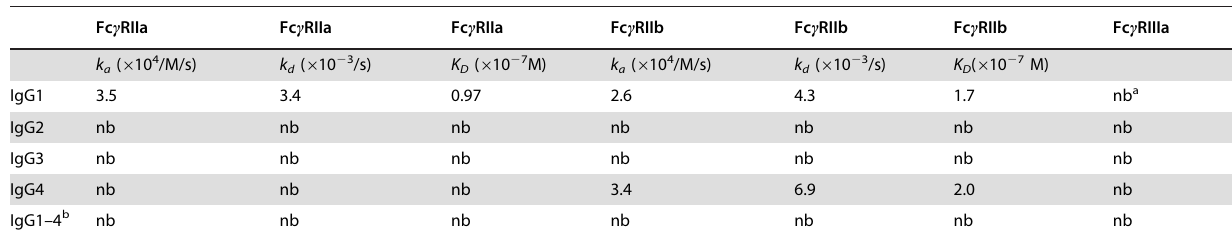
Table 2. Kinetic constants of IgG1–IgG4 binding to different Fc-receptors. .. ... .... ... ... .... ... ... .... ... ... .... ... ... .... ... ... .... ... ... .... ... ... .... ... ... .... ... ... .... ... ... .... ... ... .... ... ... .... ... ... .... ... ... .